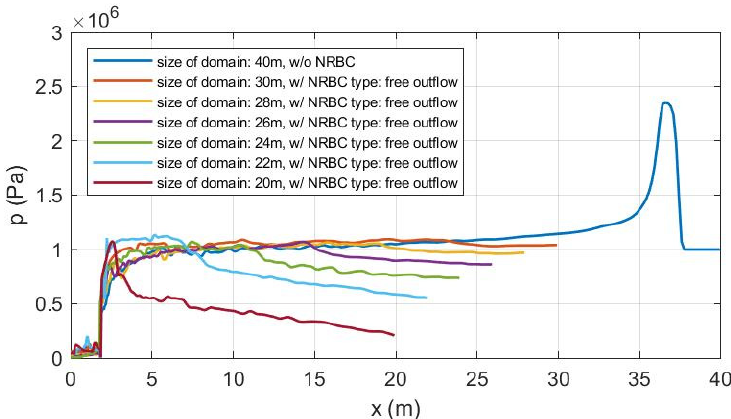
Figure 24. Free outflow type of NRBC, and its performance.